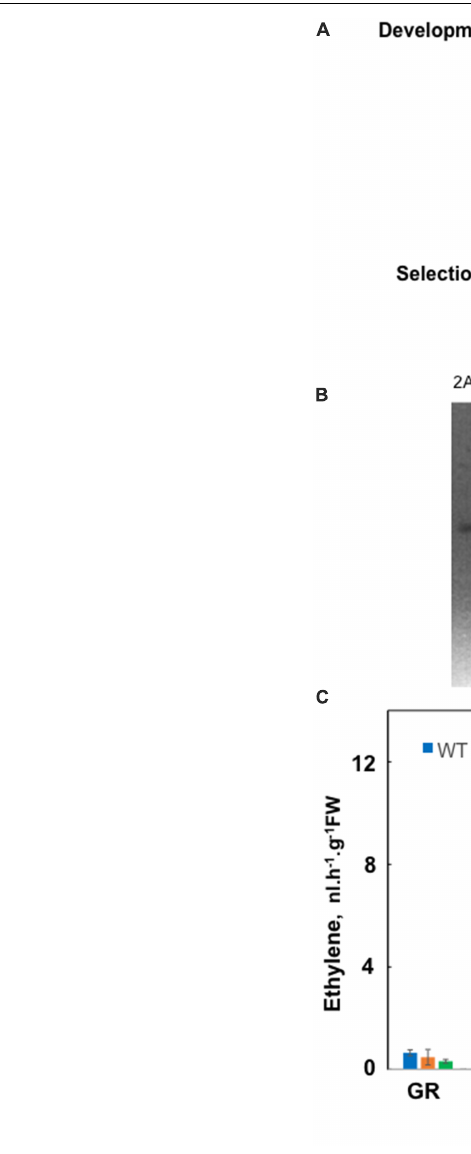
FIGURE 4 | Generation and characterization of transgenic ACS2-AS and development of double transgenic tomato line expressing both CaMV35S-ACS2-AS and E8:ySAMDC transgenes. (A) F1 line was developed by pollinating 2AS-AS (2AS-HO) flower with pollen from 579HO line. Plants from the resulting heterozygous seed were characterized. Those that showed presence of both transgenes by RT-PCR confirmed the heterozygote and then their seeds were collected. Fifty segregating seeds from F1 line were grown to maturity and from each segregating line seeds were collected individually. About 20 seedlings from each segregated seed were evaluated for the presence of both transgenes to identify